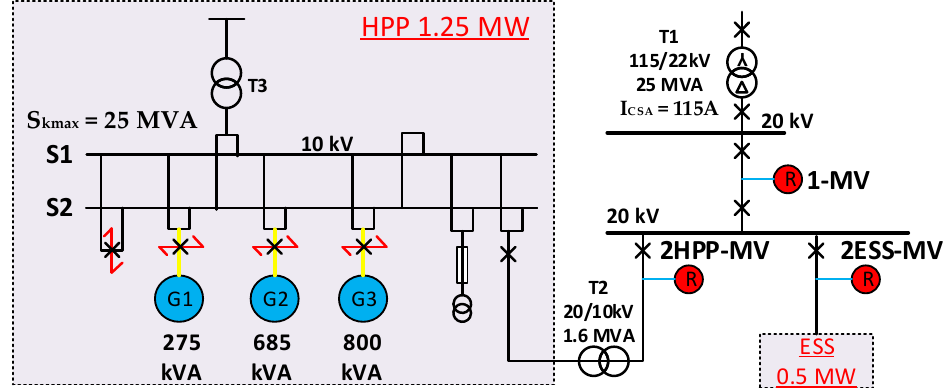
Figure 1. Investigated object of VPP with the location of PQ recorders, where 2HPP-MV: Hydro power plant with medium voltage, 2ESS-MV: Medium voltage energy storage system, and 1-MV: medium voltage line.